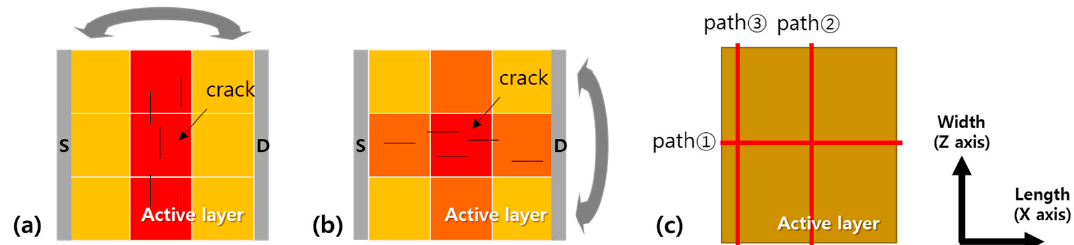
Figure 4. Division of active layer based on strain distribution under ( a ) perpendicular and ( b ) par-